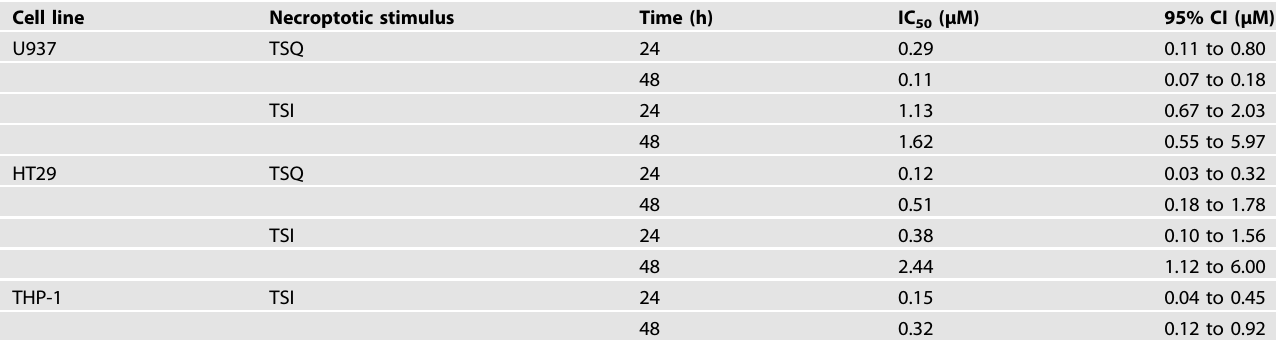
Fig. 3 AMG-47a is a strong necroptosis inhibitor in human cell lines. A – F AMG-47a was assessed in human U937, HT29 and THP-1 cell lines in 2-fold dilution series for both toxicity (AMG-47a alone), and its ability to protect against induction of necroptosis using TSI. Cell death was assessed 24 h ( A , C , E ) or 48 h ( B , D , F ) after treatment by measuring propidium iodide (PI; 1 µg/ml) uptake using fl ow cytometry, with a minimum of 5000 cells counted. Data represent three ( A , B , E , F ) or four ( B , D ) independent biological replicates, and lines represent the mean. Table 1. IC 50 values of AMG-47a in human cell